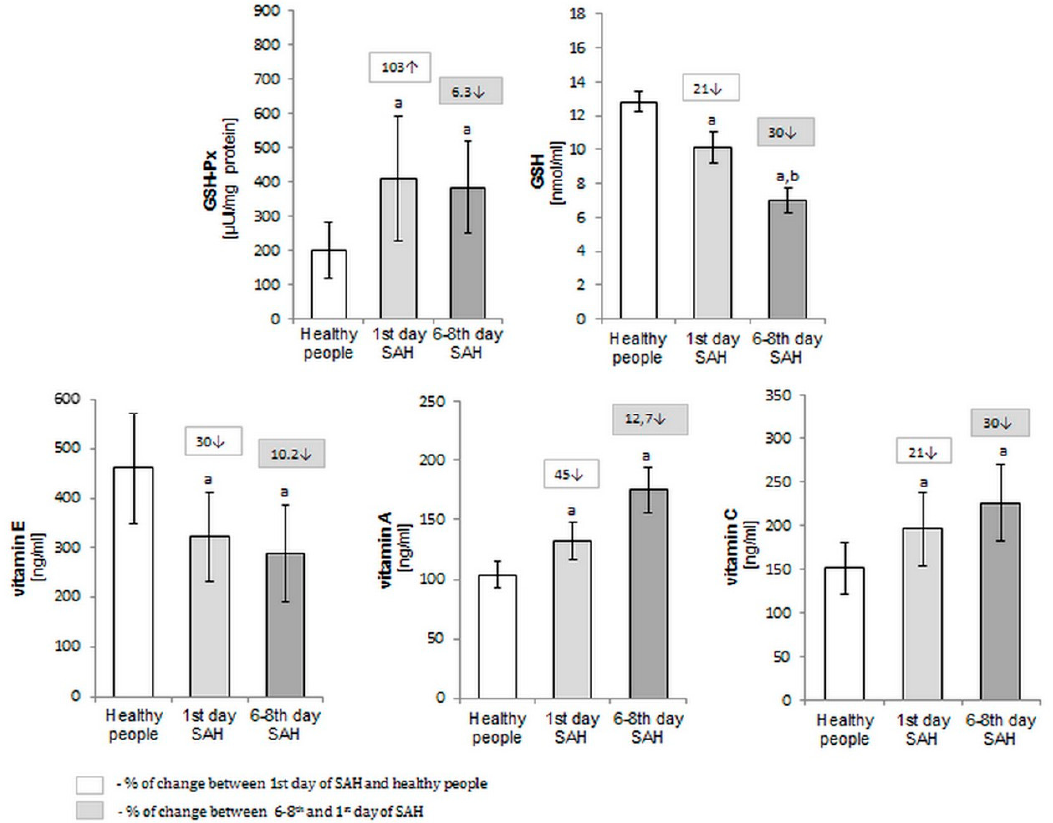
Figure 1. The antioxidants activity (GSH-Px) and level (GSH and vitamins A, E, and C) in the plasma of healthy people ( n = 30) and SAH-patients ( n = 30) at the 1st and 6–8th day after SAH; a p < 0.05 in comparison with healthy people. b p < 0.05 in comparison with patients on the 1st day after SAH.